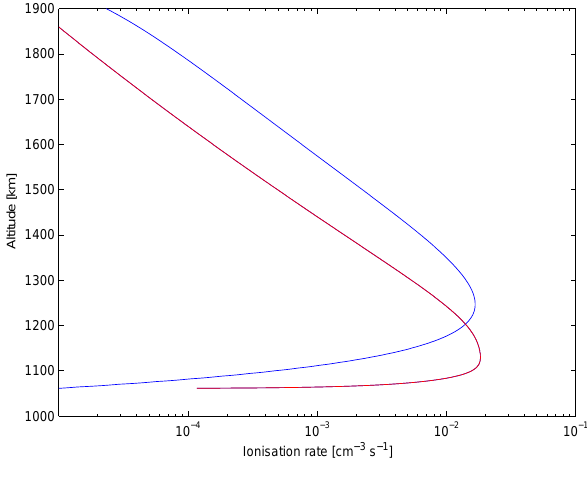
Fig. 9. Ion (N + 2 ) production rates (q) for 30 eV (blue) and 200 eV (red) impacting electron energies. Fluxes Fig. 9. Ion (N + ) production rates (q) for 30eV (blue) and 200eV 2 are 7 . 9 × 10 5 cm − 2 s − 1 and 1 . 3 × 10 5 cm − 2 s − 1 respectively. The rates for 30 eV electrons are large at high (red) impacting electron energies. Fluxes are 7 . 9 × 10 5 cm − 2 s − 1 altitudes, and n e /q < 2 π/ Ω i (an ion gyroperiod) in the exo-ionosphere. and 1 . 3 × 10 5 cm − 2 s − 1 respectively. The rates for 30eV electrons are large at high altitudes, and n e /q< 2 π/(cid:127) i (an ion gyroperiod) in the exo-ionosphere.